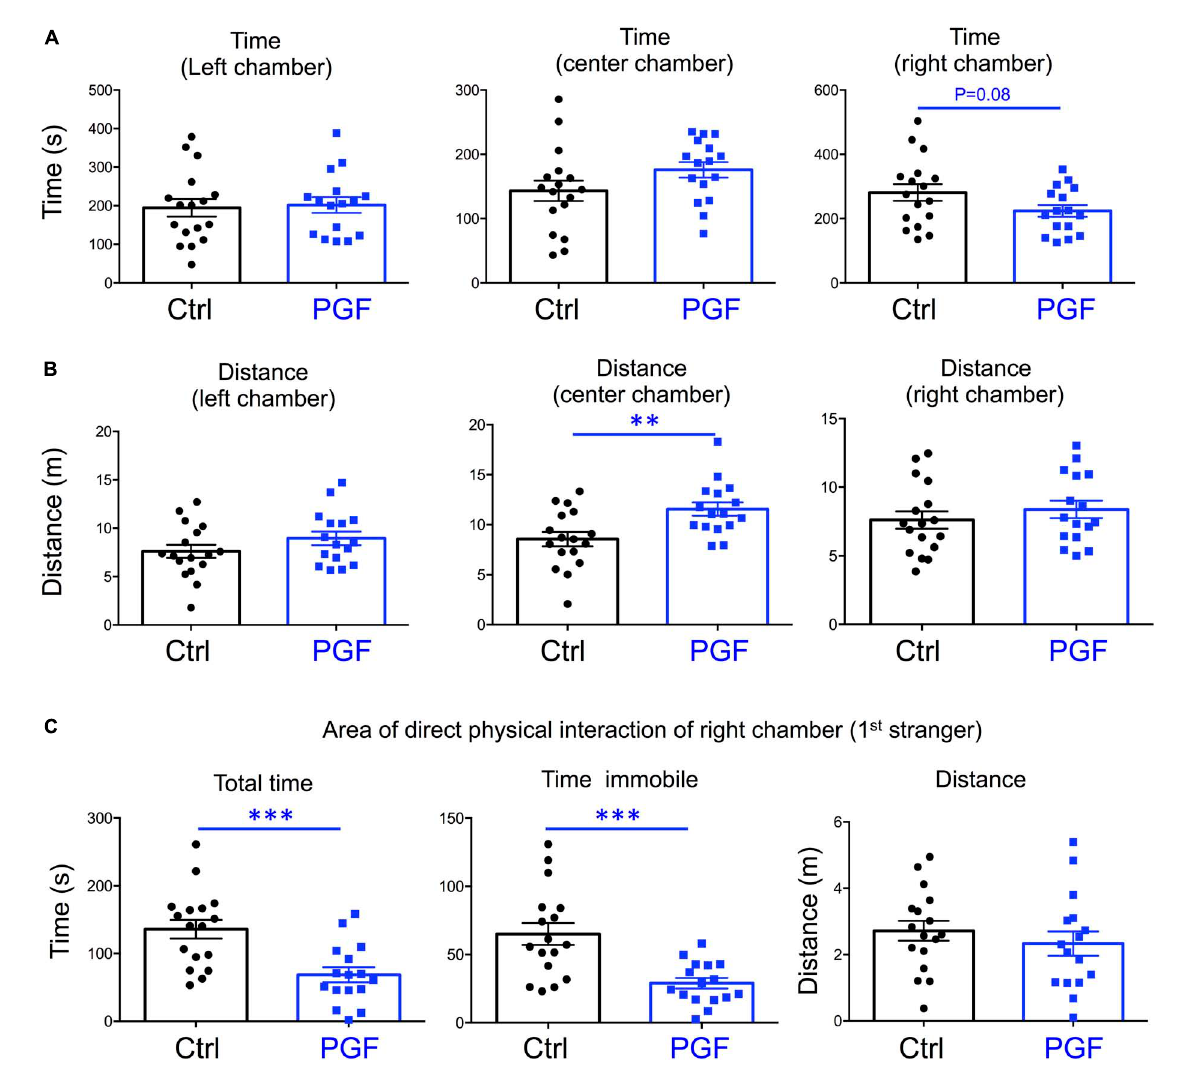
FIGURE3 Sociability of PGF males. (A–C) Second trial of the three-chamber social box test, after first stranger is introduced in the right chamber. (A) Time spent by the test mouse in each chamber. (B) Distance traveled by the test mouse in each chamber. (C) Total time, time immobile, and distance traveled by the test mouse in the area immediately around the 1st stranger in the right chamber. Each point represents a different mouse tested at approximately 18 weeks of age ( n = 17, 16) and mean ± SEM are shown. Experimental mice from each group represent 4 different litters and data represent two animal cohorts that were generated and tested at different dates. ∗∗ and ∗∗∗ indicate P < 0.01 and 0.001, respectively, as determined by the Student’s t